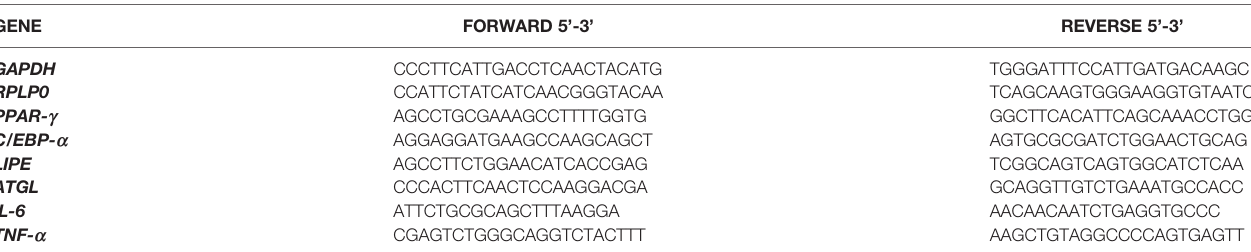
TABLE 2 | Primer sequences.